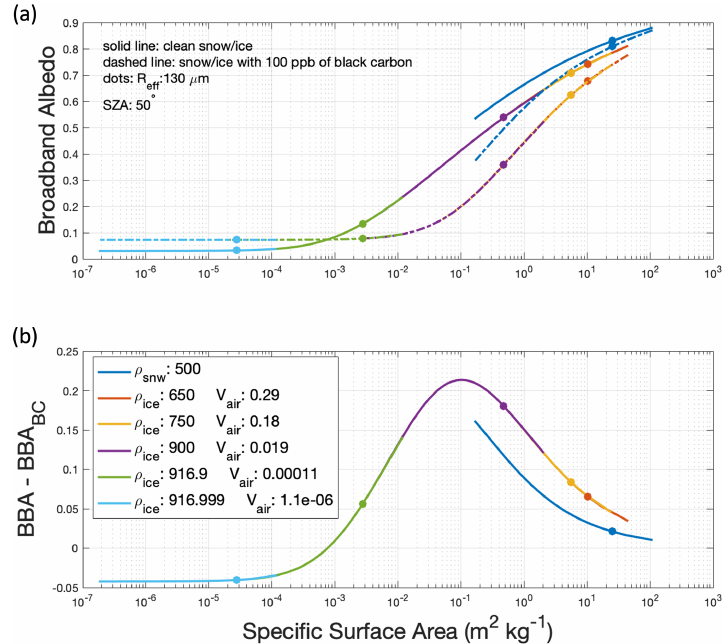
Figure 8. The impact of black carbon on snow and ice BBA as a function of SSA. Model configuration is the same as Fig. 7a. Dots indicate where the radius of the snow grain and air bubbles is 130µm. (a) Broadband albedo as a function of specific surface area; solid lines indicate clean snow/ice and dashed lines indicate snow/ice with 100ppb of black carbon. (b) The broadband albedo impact of black carbon shown as the difference between the sold and dashed lines in panel (a)